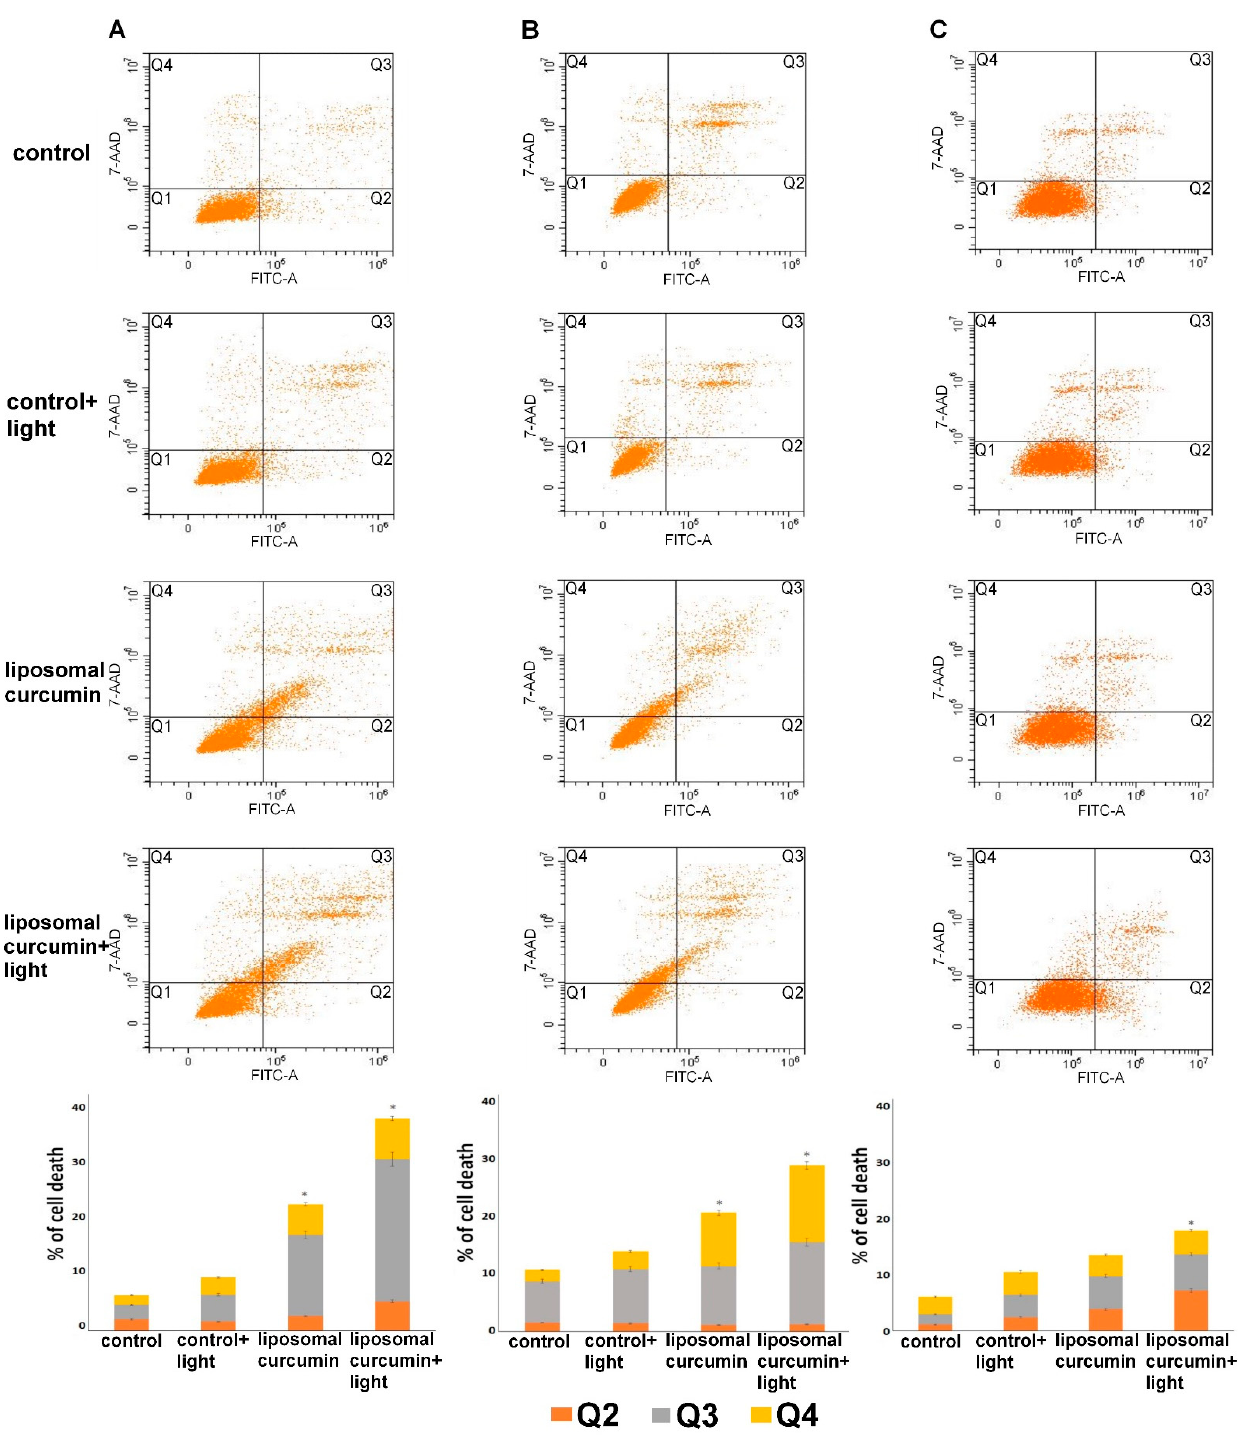
Figure 5. Effect of photodynamic therapy (PDT) with liposomal curcumin in dose 10 μ M with blue light (2.5 J/cm2) on SCC-25 ( A ), MUG-Mel2 ( B ), and HaCaT ( C ) cells. Dot plots present alive-Q1, early apoptotic-Q2, late apoptotic-Q3, and dead-Q4 cells. After therapy, the cells were stained using Annexin-FICT /7-AAD Kit and were measured by flow cytometry. Bars represents the quantitative percentage of total apoptotic cells (early + late apoptosis) and necrotic cells in SCC-25, MUG-Mel2, and HaCaT cells. Results represent the mean from three different experiments. p < 0.05.